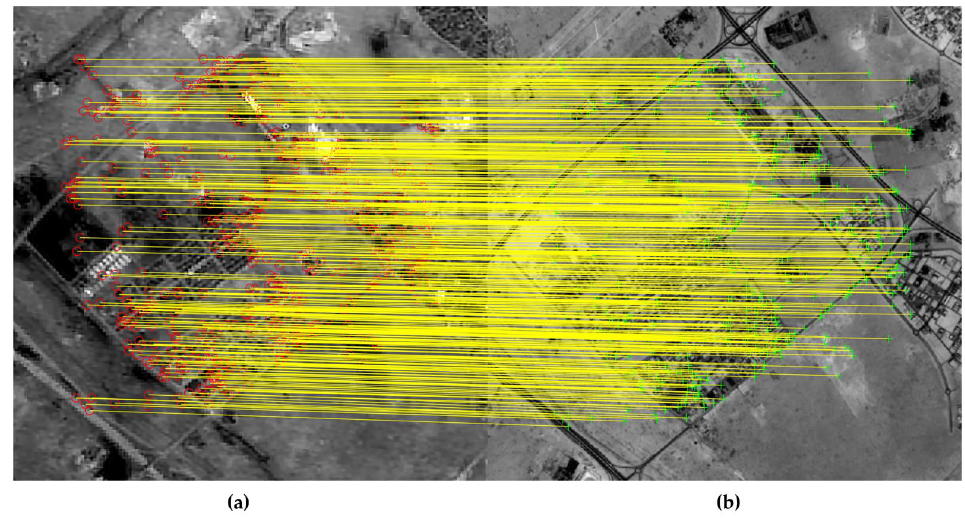
Figure 4. Point pairs extracted with RIFT. ( a ) B3 image of SDGSAT-01 TIS with the original resolution of 30 m; ( b ) B8 image of Landsat8 OLI with the original resolution of 15 m.